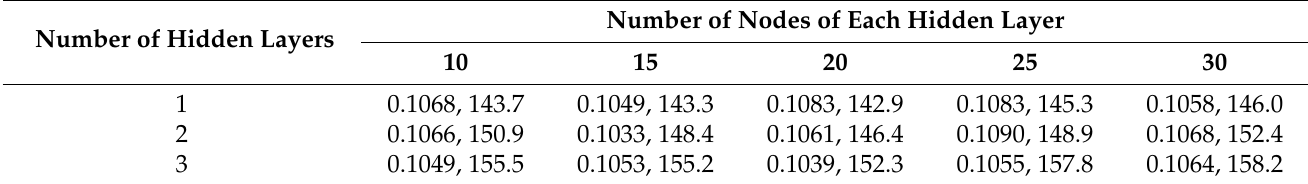
Table 5. Validation losses and training time (s) of the p2p module with different hyperparameters. Number of Hidden Layers